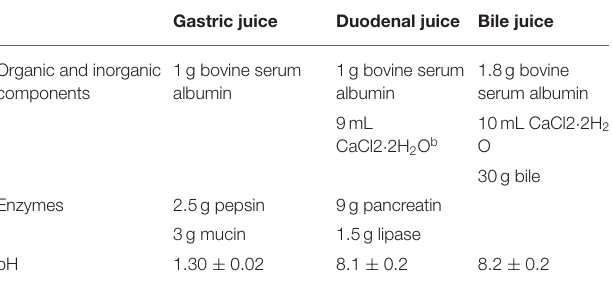
TABLE 1 | Constituents of the synthetic juices of the protein digestion model a . Gastric juice Duodenal juice Bile juice